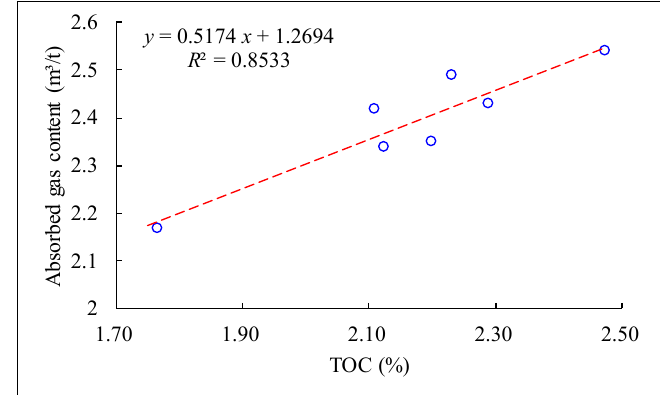
Figure 11. The isothermal adsorption characteristics of the Xinkailing formation in Wuning, related to pressure.